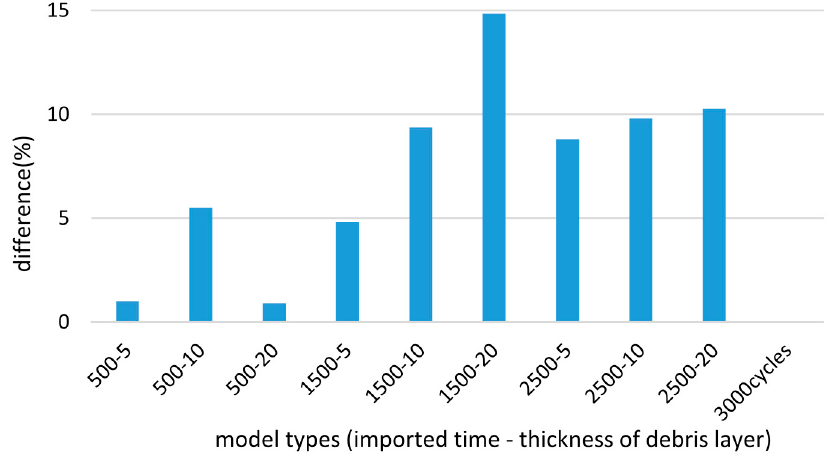
Figure 18. Difference of wear damage compared to the case of basic model, after 3000 cycles.